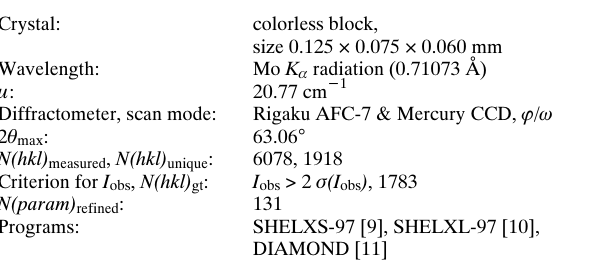
Table 1. Data collection and handling.